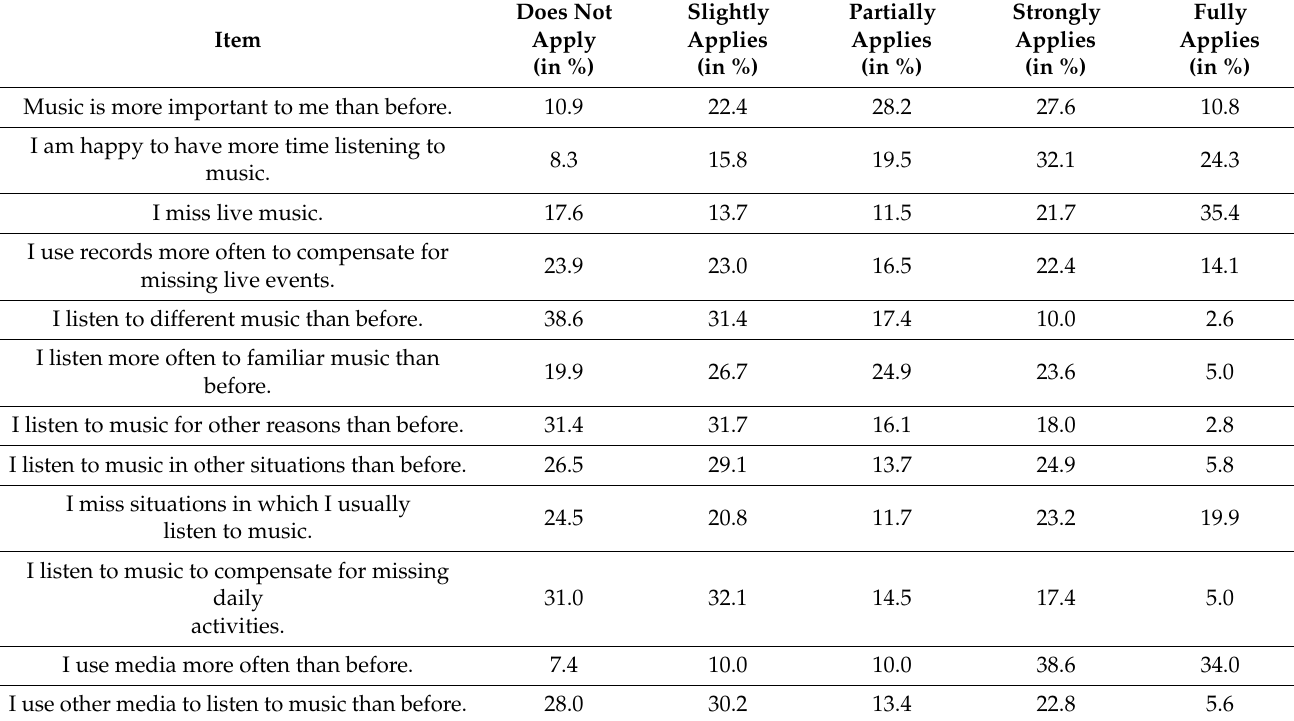
Table 6. Perceived differences in music-listening